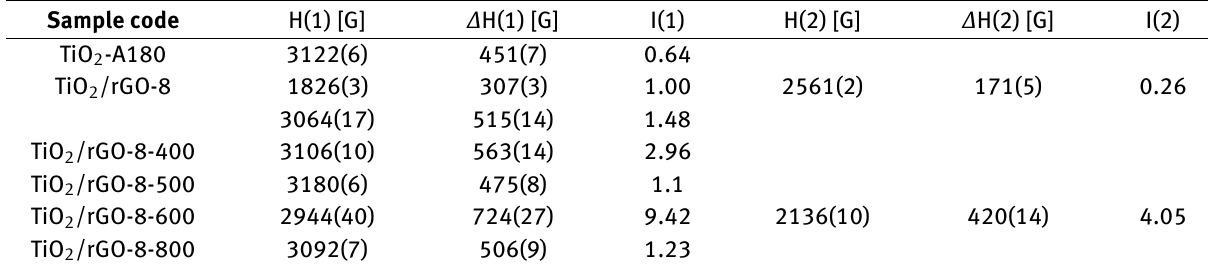
Table 2: The resonance field (H), linewith ( ∆H ) and integrated intensity (I) (related to the second sample) for broad line Sample